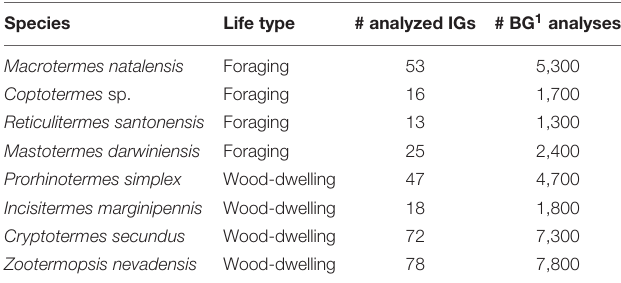
TABLE 3 | Number of analyzed IGs with HyPhy-BUSTED and RELAX and respective BG analyses with HyPhy-RELAX for each of the included termite